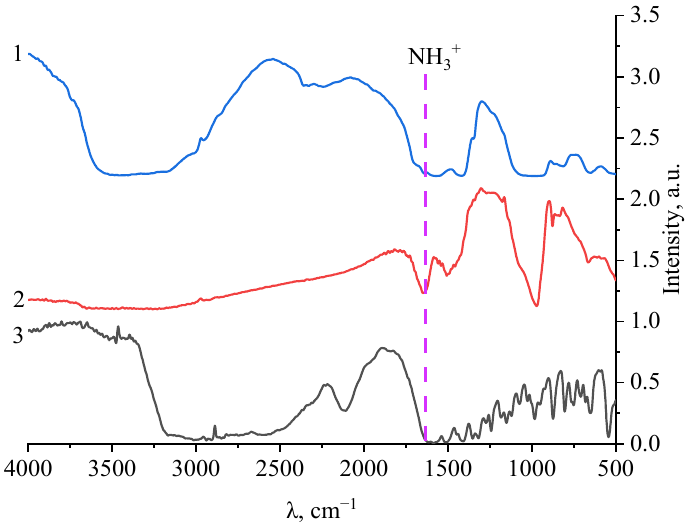
Figure 7. IR spectra: 1—calcium silicate; 2—calcium silicate stabilized with L − methionine; 3—L − me- thionine.